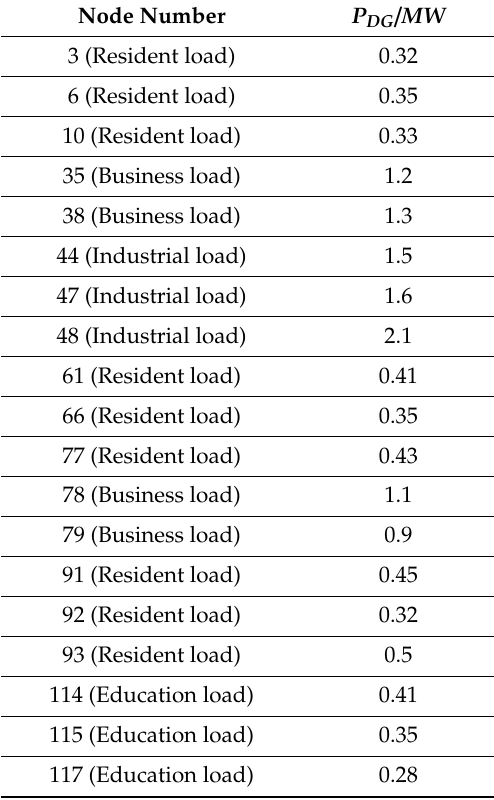
Table 6. Optimized configuration